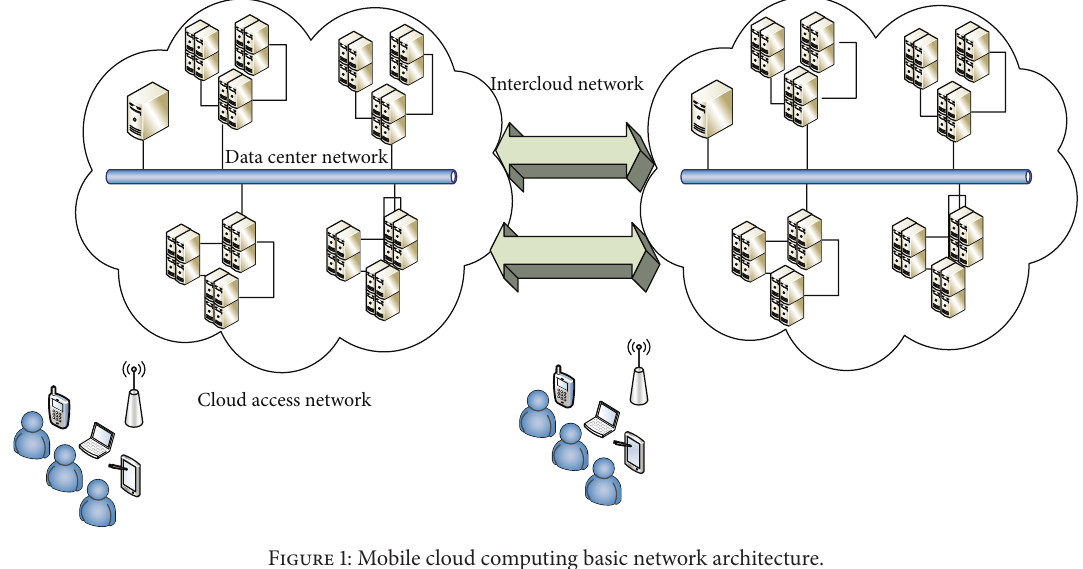
Figure 1: Mobile cloud computing basic network architecture.